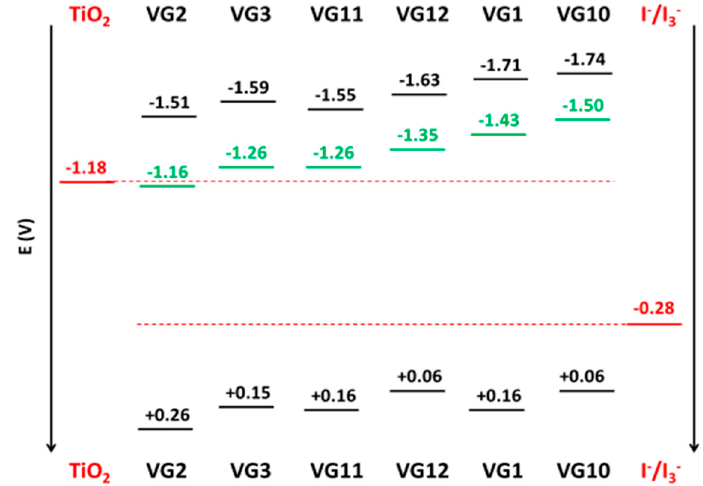
Figure 4. HOMO and LUMO energy levels (black) and E red potentials (green) of the four novel squaraine dyes vs. Fc/Fc + (in V); VG1 and VG10 dyes are reported as a comparison [11].